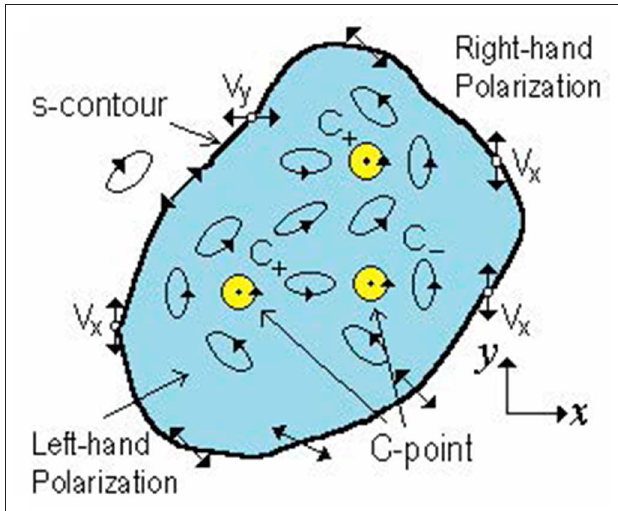
FIGURE 6 | The field fragment with s -contour and a set of C -points. The OVs of the u x and u y components (see Equation 3) lie on the s -contour and are indicated by V x and V y , respectively